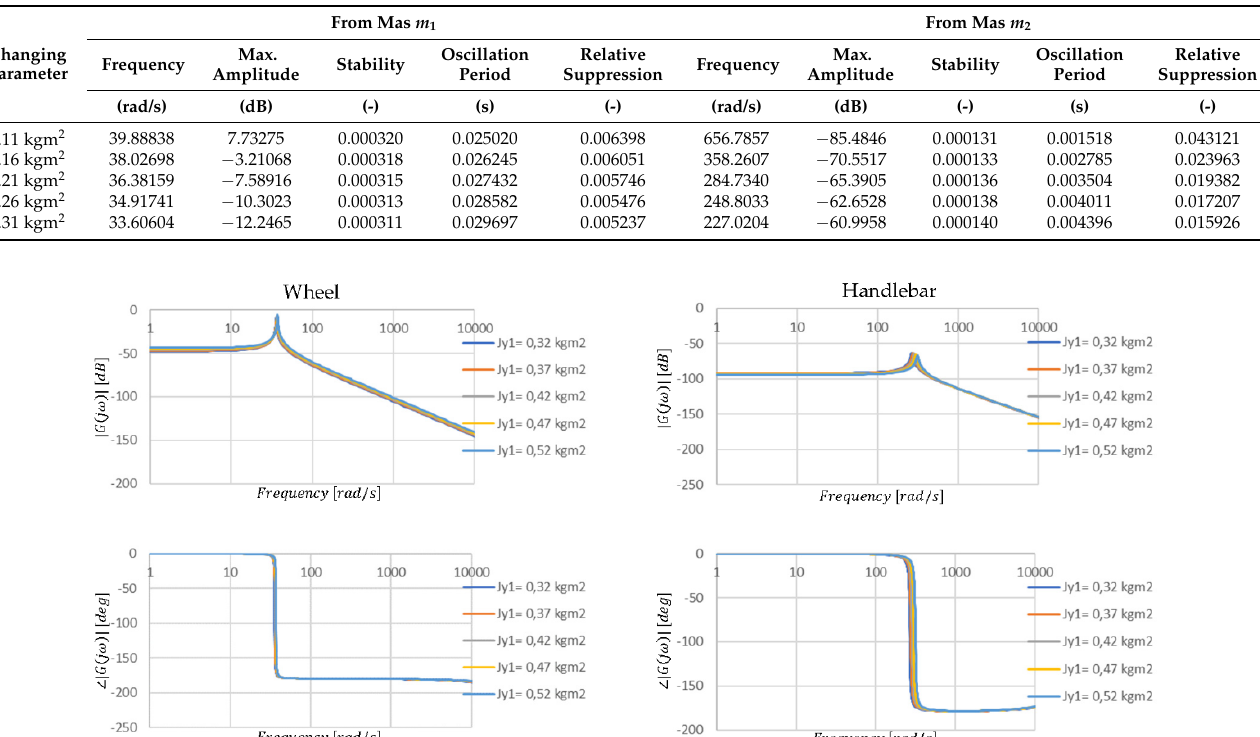
Figure 9. Amplitude and phase characteristics of the transmittance of the steering angle position when the parameter value is changed J y 1 . Table 4. The values of the parameters read from the graphs shown in Figure 10.